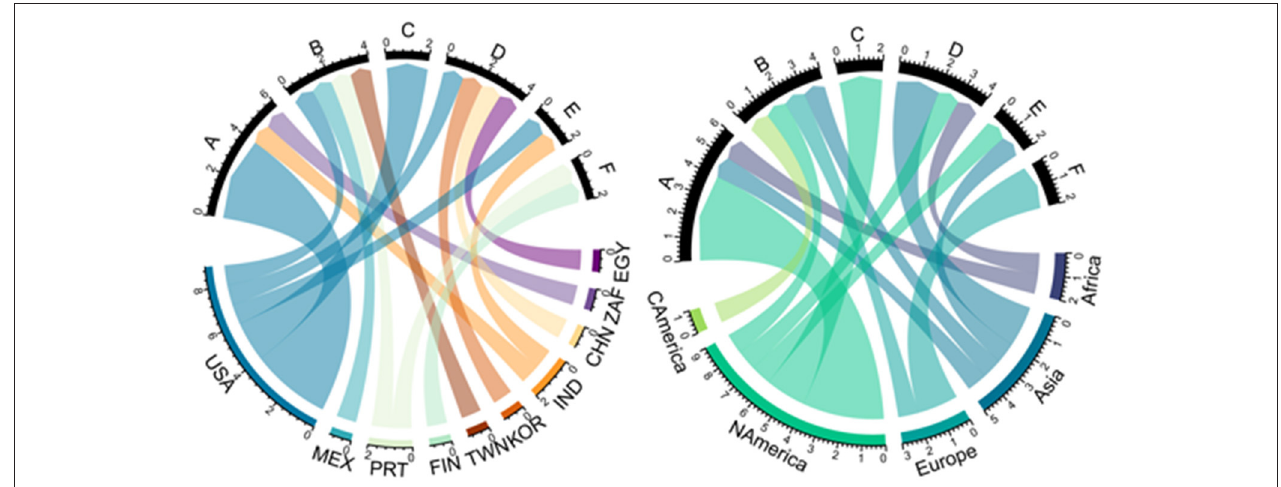
FIGURE 2 | The distribution of countries ( left ) and continents ( right ) in the taxonomy.